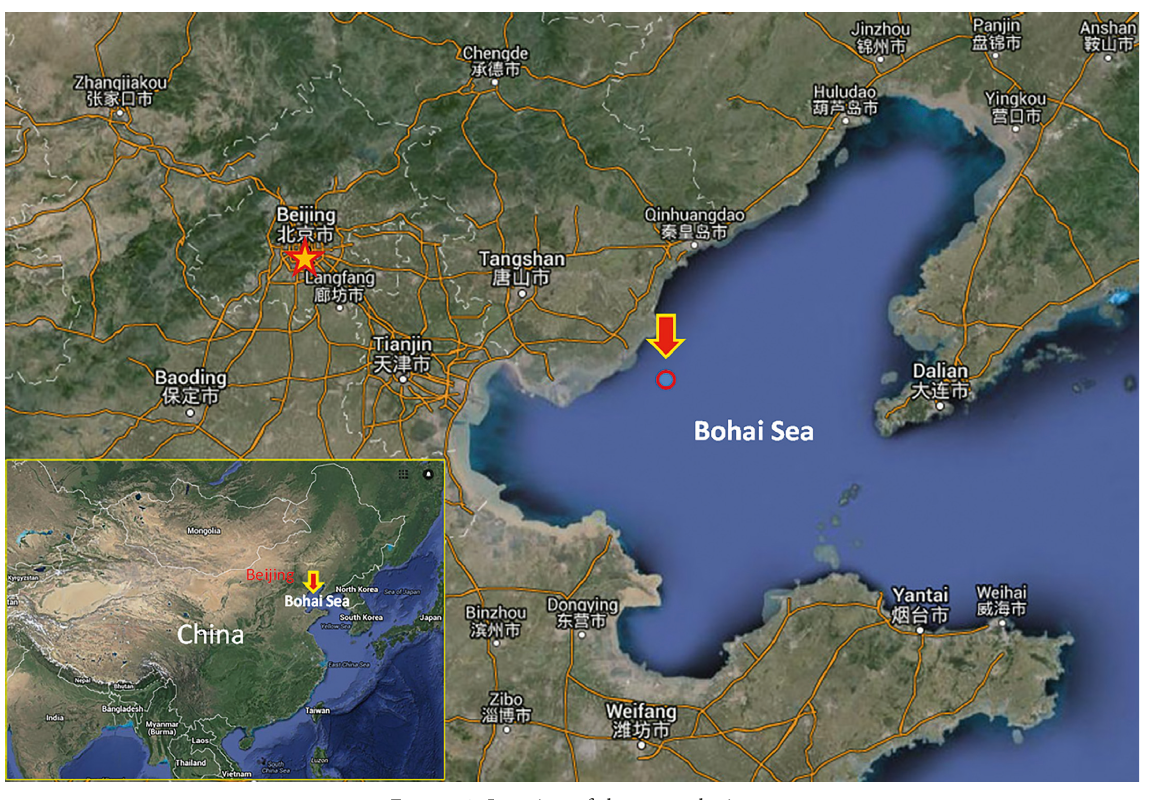
Figure 1: Location of the research site.